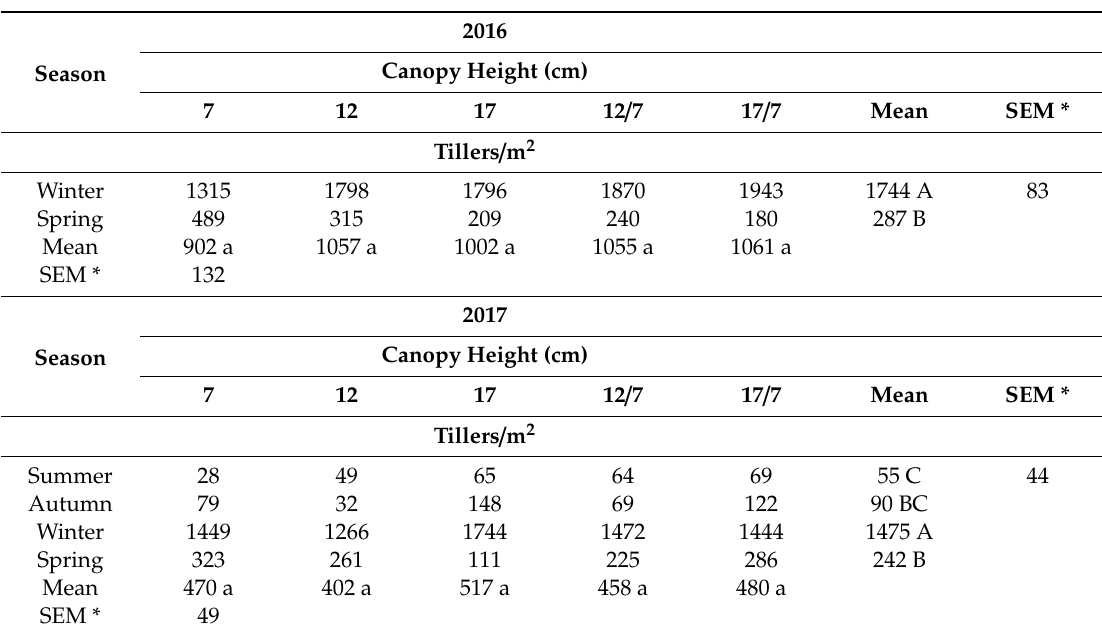
Table 3. Absolute number of emerged tillers of tall fescue (tillers / m 2 ) in mixed canopies of kikuyu-grass and tall fescue submitted to grazing, in di ff erent